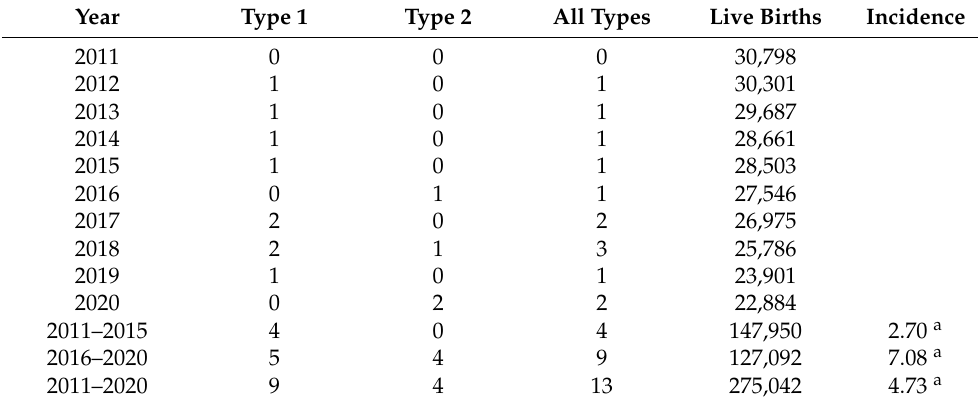
Table 2. Patients with infantile SMA during 2011–2020 on Shikoku.